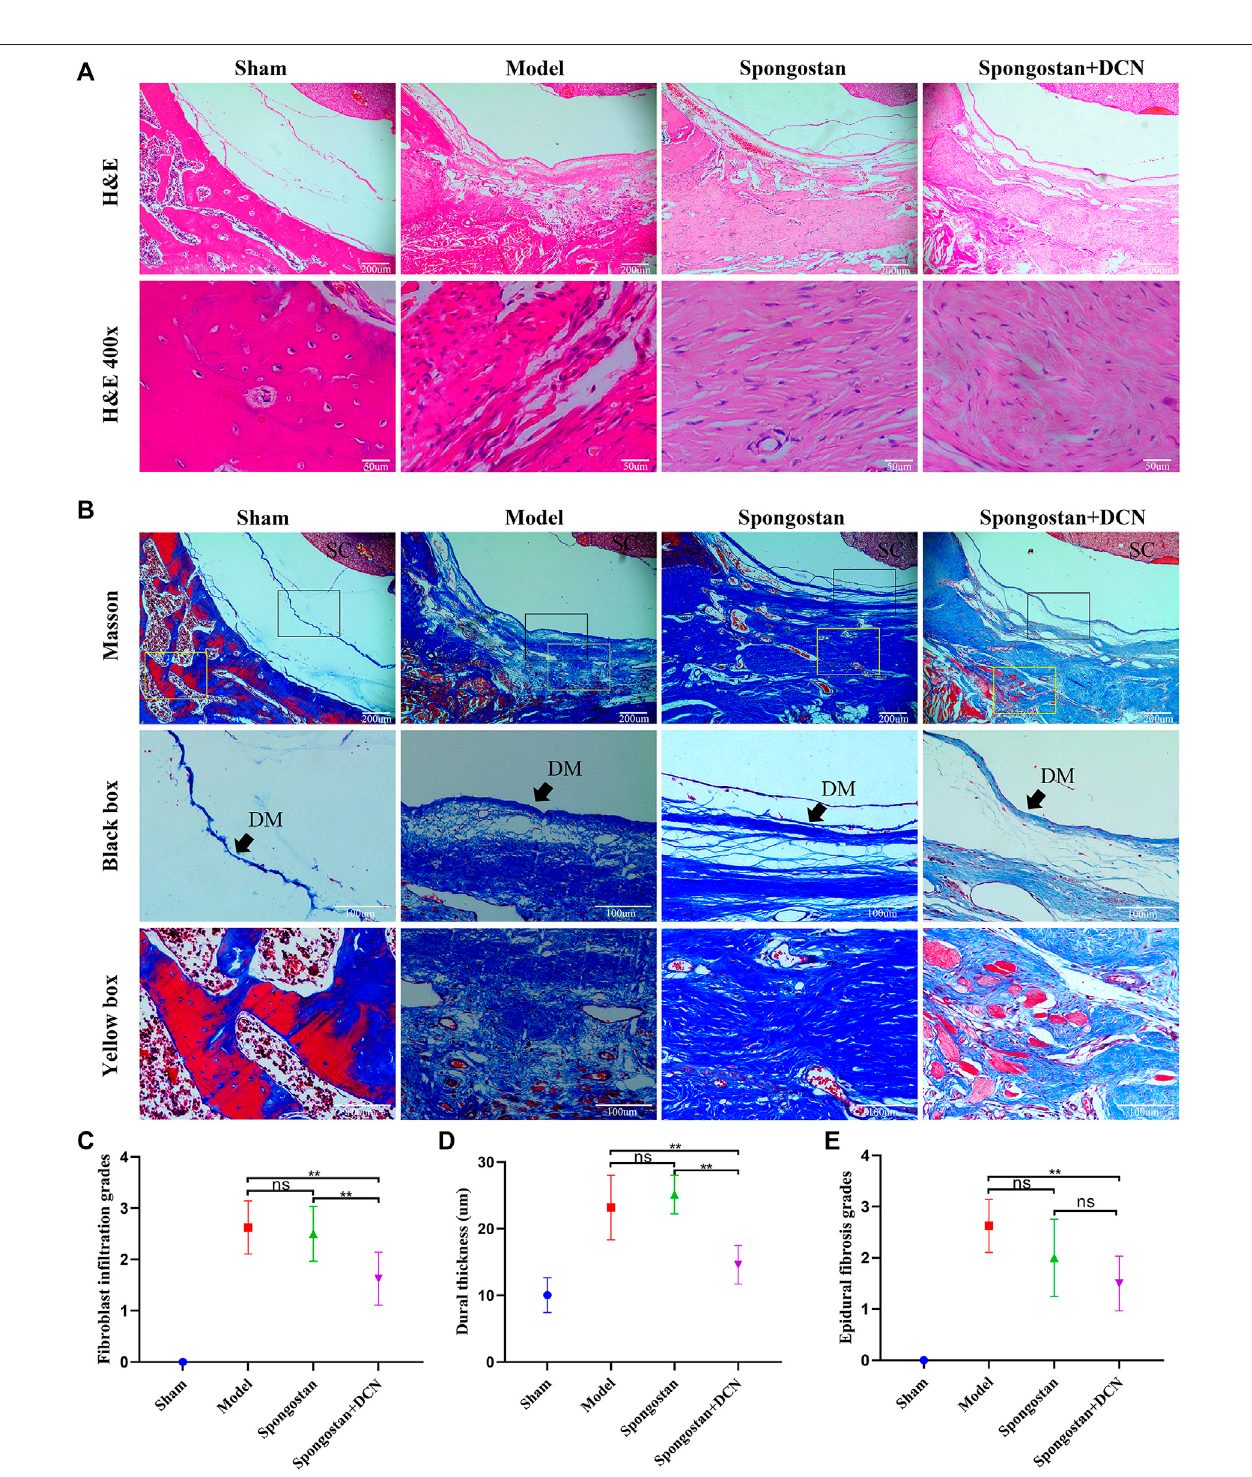
FIGURE8| RepresentativeH&EstainingandMassonstainingfromeachgroupat4 weekspostoperatively. (A) H&Estainingofspinalcolumninlaminectomysites. The high-resolution images (400 × ) in the bottom panel show fi broblast in fi ltration. (B) Masson-stained sections of laminectomy sites. DM, dura mater; SC, spinal cord. (C) Quanti fi ed fi broblastin fi ltrationgradesathighresolution(400 × ). (D) Comparisonofduralthicknessamonggroups. (E) Quantitativeanalysisofepidural fi brosisgrades according to Masson-stained sections. * p < 0.05; ** p < 0.01.